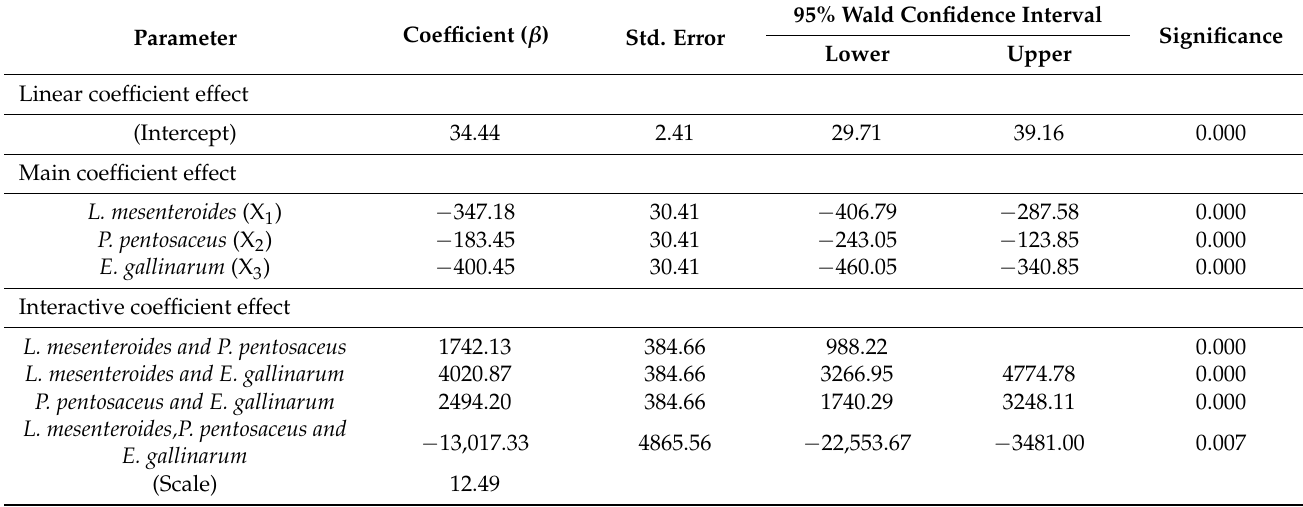
Table 9. The generalized linear model for the effects of L. mesenteroides, P. pentosaceus and E. gallinarum and their interaction on the viscosity of pearl millet